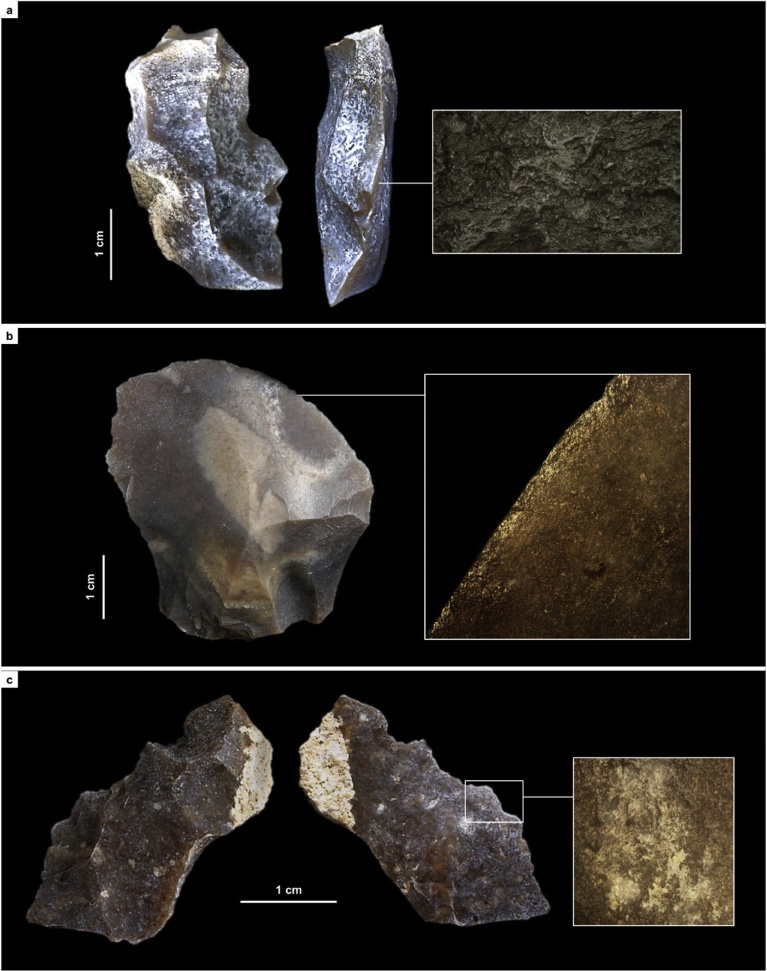
Middle Paleolithic wood-working tools in the Mula basin sites. a. Denticulate from Cueva Antón (layer I-k). b. Unretouched blank from La Boja (OH23). c. Denticulate from La Boja (OH23). The insets show characteristic microscopic polish. Note the similarity of the two denticulates, both made on orange-segment or discoid-overshot blanks; denticulates of this kind are entirely absent from top to bottom of the long and complete Upper Paleolithic sequences of La Boja and Finca Doña Martina (for additional detail, see the SI appendix).